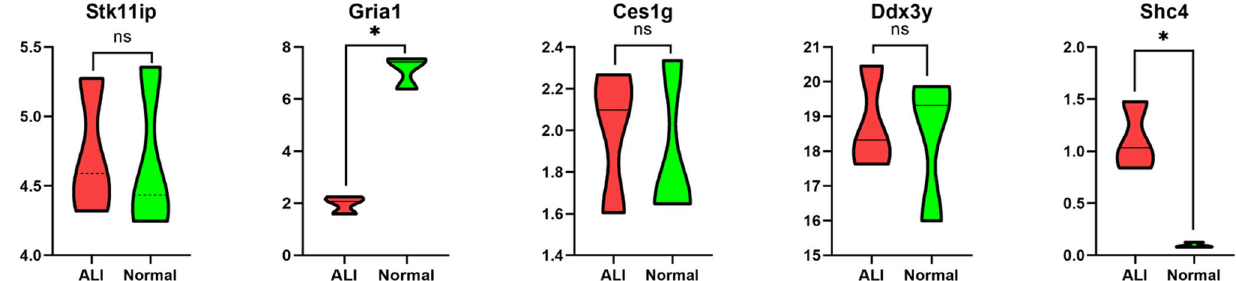
Figure 7. Expression levels of target genes from the GSE109913 dataset. The expression levels of Gria1 were significantly lower in bleomycin-treated ALI samples than in normal control samples, and the expression levels of Shc4 were significantly higher in bleomycin-treated ALI samples than in normal control samples. ns: no significance, *P < 0.05.